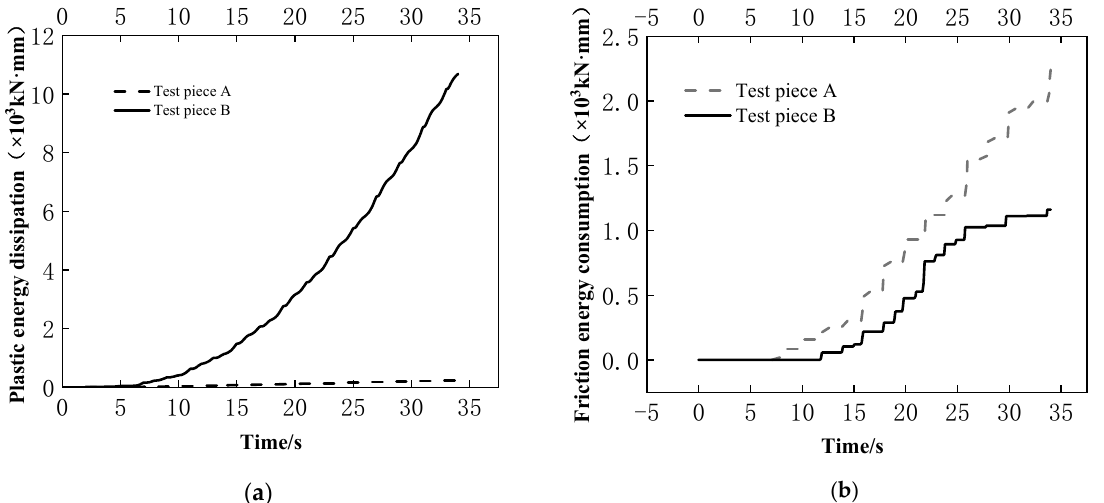
Figure 12. Comparison of friction energy consumption and plastic energy consumption curves. ( a ) Plastic energy dissipation curve. ( b ) Friction energy dissipation curve.